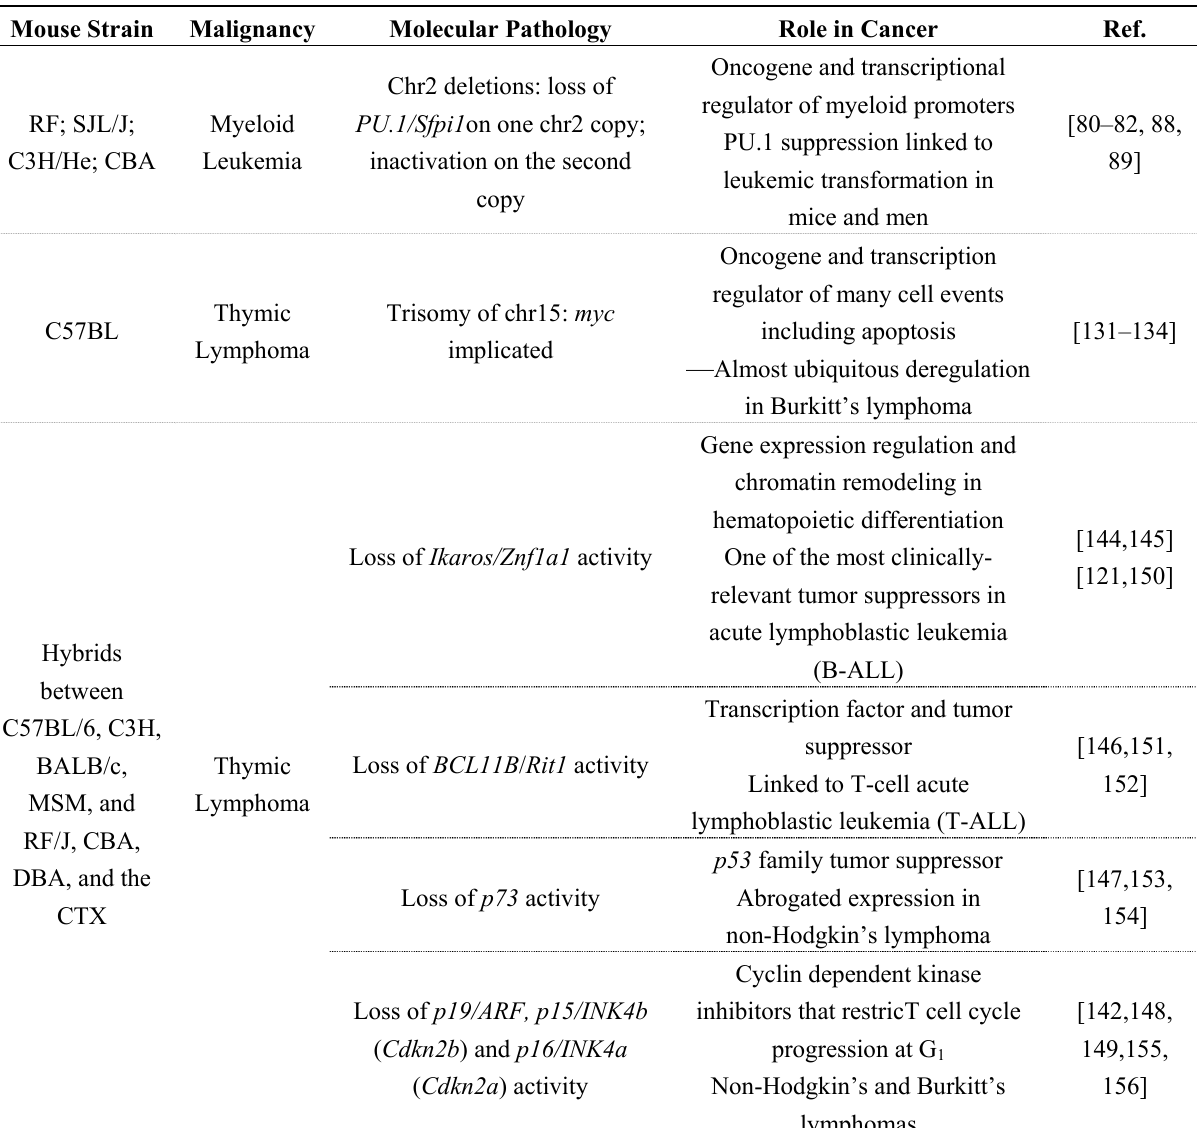
Table 3. Relevant molecular pathologies in murine RI leukemia and lymphoma. Mouse Strain Malignancy Molecular Pathology Role in Cancer